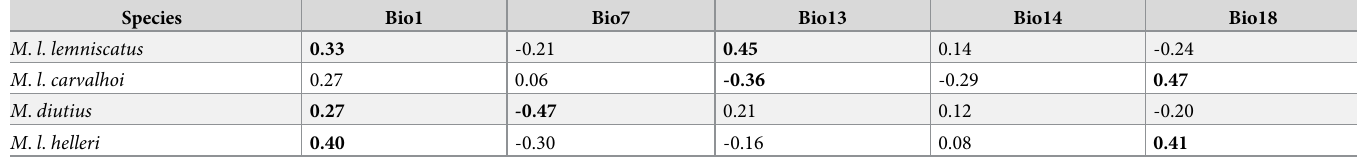
Table 3. Standardized regression coefficients from the multiple regression models between habitat suitability and the bioclimatic variables. Bold values indicate the two most important variables (i.e., with the higher coefficient values) for each species. Species